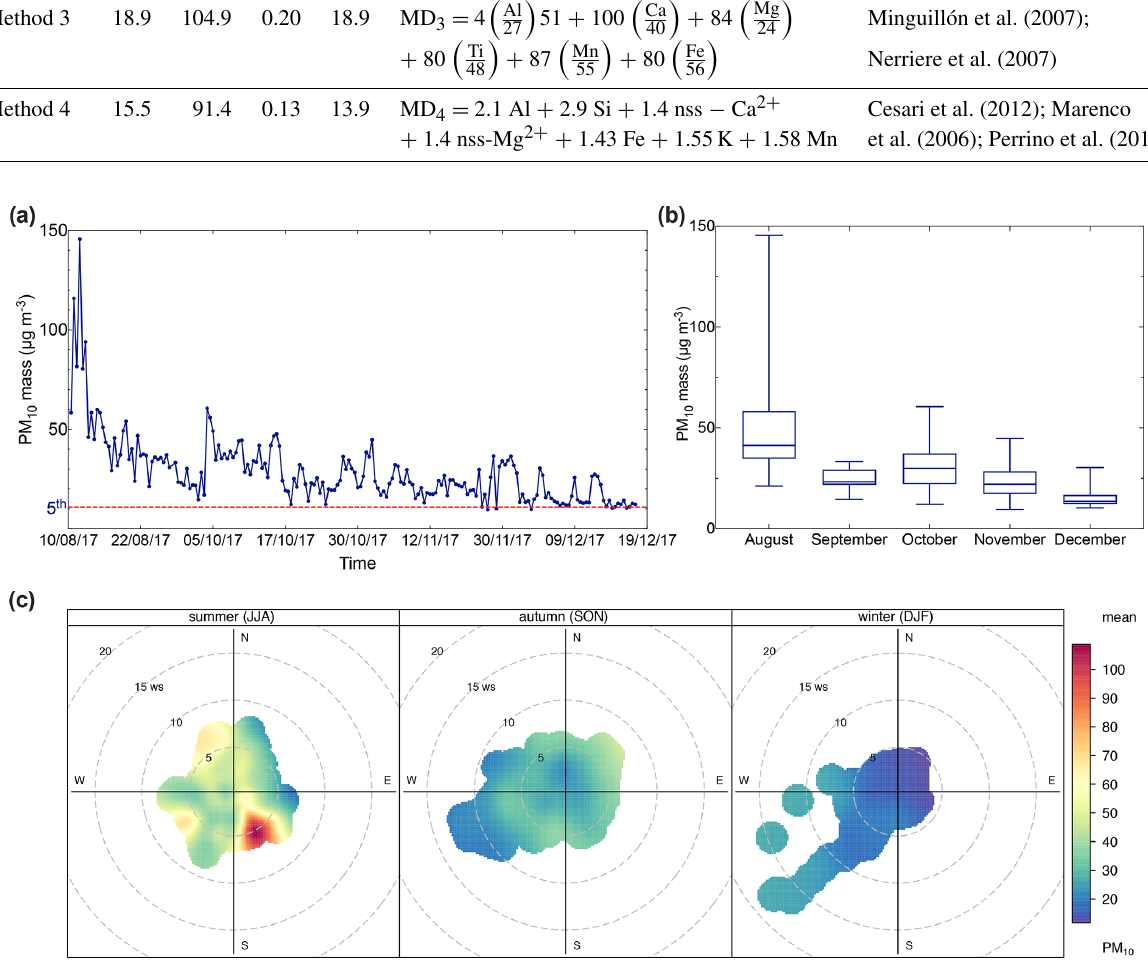
Figure 3. (a) Time series of daily PM 10 mass; (b) box plot of monthly averages of PM 10 mass; (c) pollution rose of PM 10 mass. The presented data were separated according to each season into summer (August), fall (September–November), and winter (December). Time series of daily PM 10 mass, with the dotted line representing the 5th percentile of the